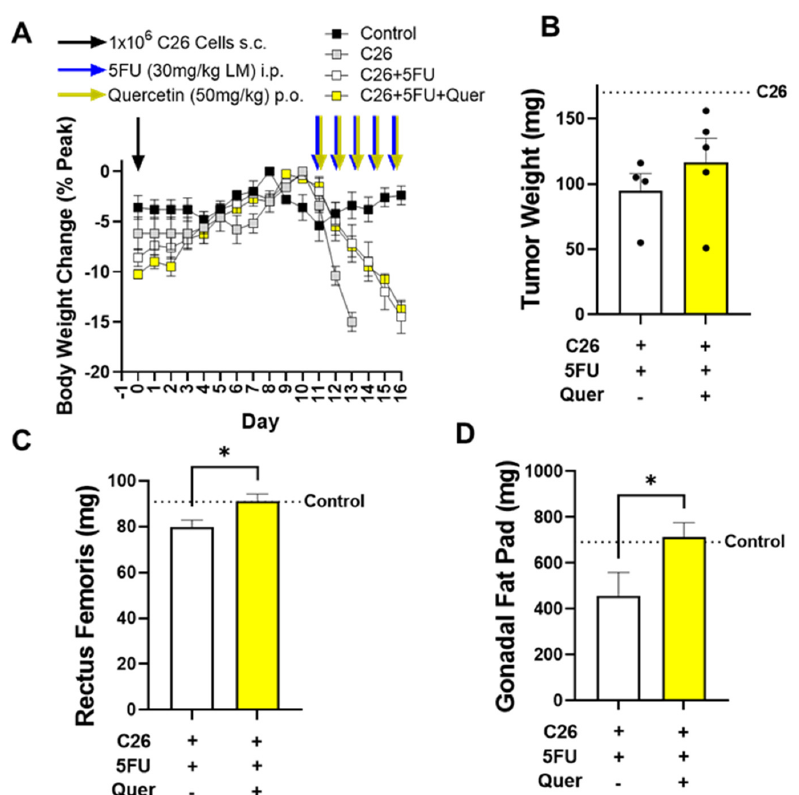
Figure 1. Quercetin’s impact on body and tissue weights. ( A ) Body weights shown as a percent of each mouse’s peak body weight over the course of the study. Mice were injected with 1 × 10 6 C26 cells subcutaneously (s.c.) at Day 0. Mice were then given 5FU at 30 mg/kg of lean mass (LM) via intraperitoneal (i.p.) injection starting at Day 11. Mice were also administered either quercetin (n = 5) at 50 mg/kg body weight or propylene glycol (n = 5) via oral gavage (per os; p.o.) starting at Day 11. ( B ) Tumor weights in milligrams (mg) taken at euthanasia. An additional cohort of mice given C26 without 5FU are shown as reference point (dotted line) for tumor growth without